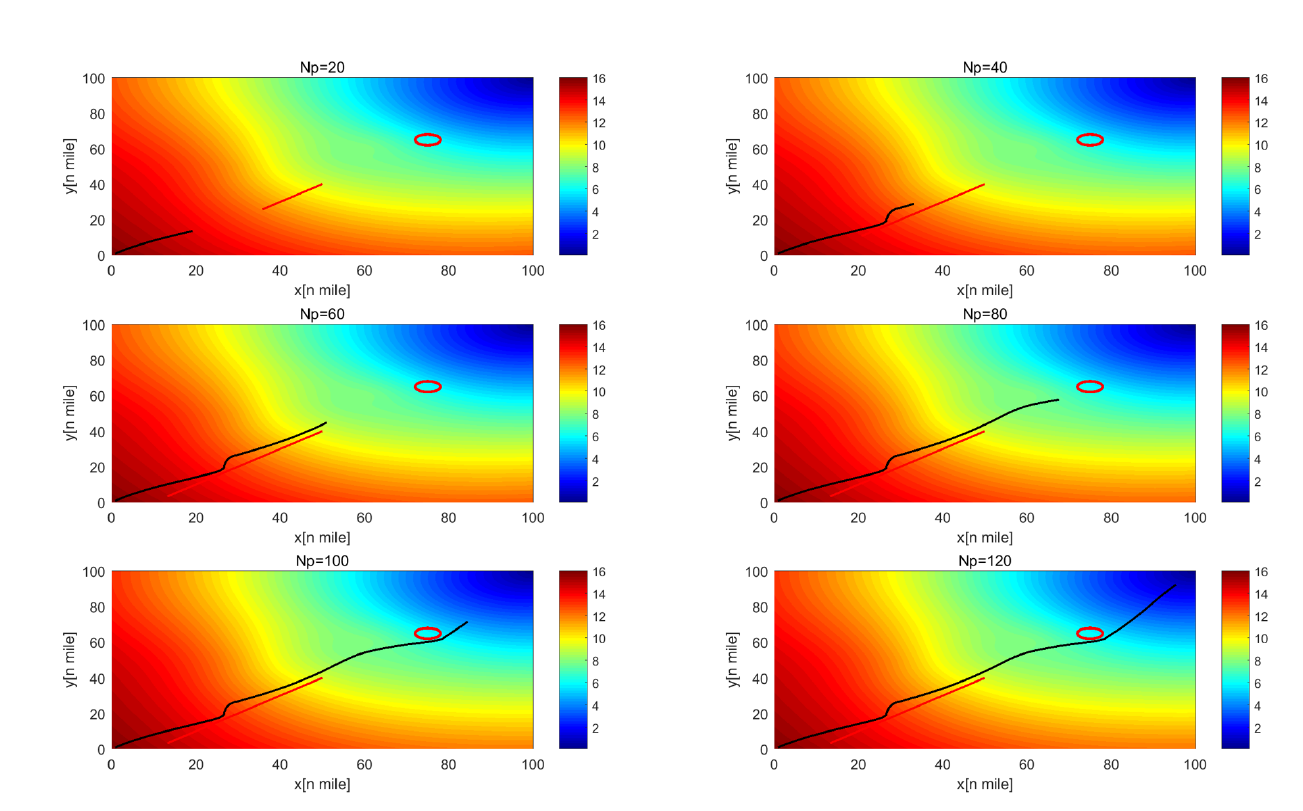
Figure 17. Trajectory of RHNC system with collision avoidance and event triggering.